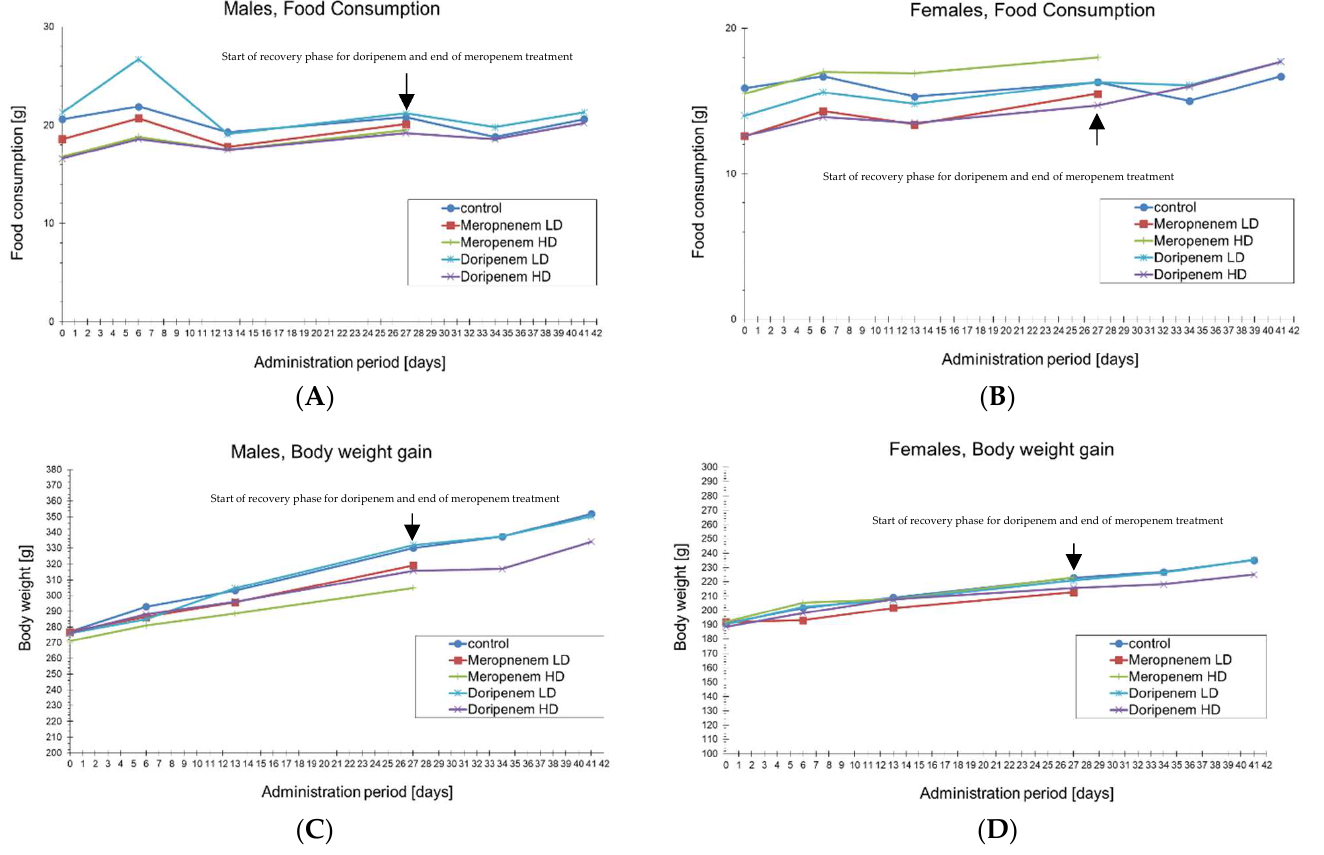
Figure 2. Line plots representing food consumption (in grams) and body weight (in grams), in male ( A , C ) and female ( B , D ) animals, respectively, compared to the controls and different antibiotics treatment groups on days 0, 6, 13, and 27 and additionally on days 35 and 42/43 for the doripenem- recovery groups. The end of meropenem treatment and the start of doripenem-recovery groups have been highlighted with black arrows. Changes in body weight and food consumption were compared between control and treated groups and showed no significant differences ( p -value < 0.05).